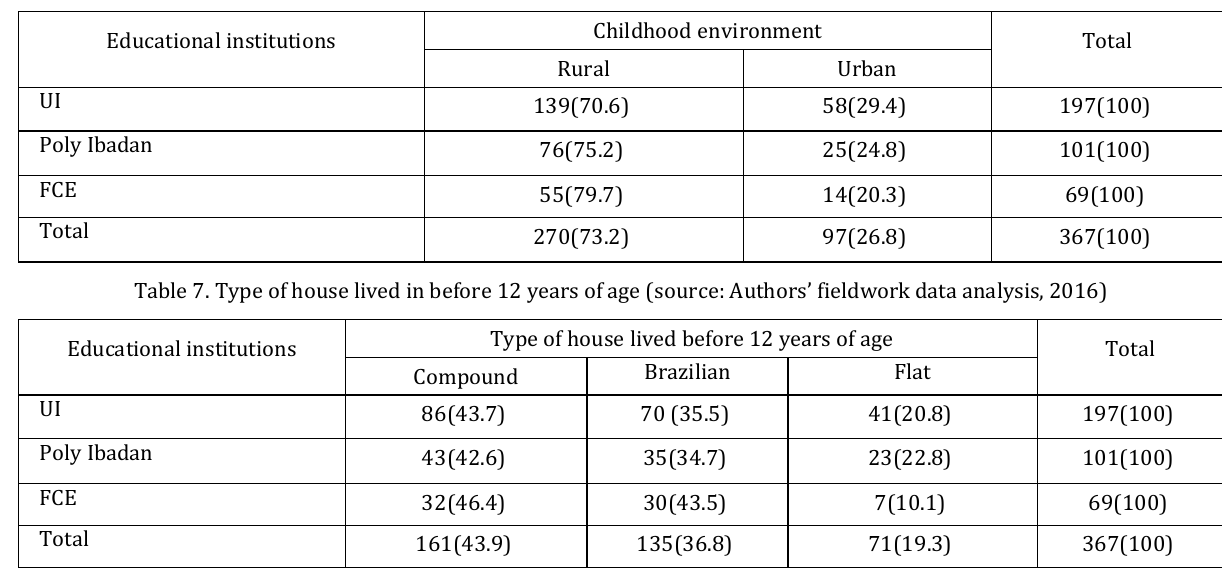
Table 6. Childhood environment of students (source: Authors’ fieldwork data analysis, 2016)